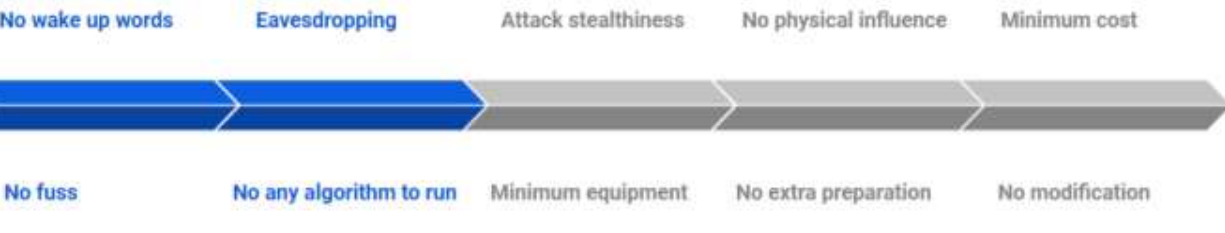
Figure 18. The advantage of this attack over previous